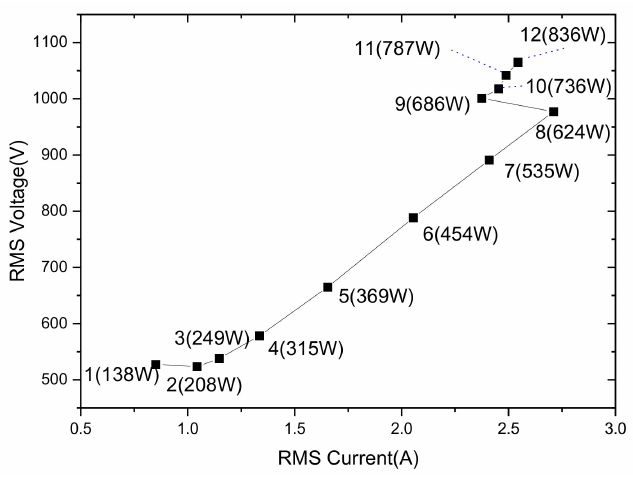
Figure 2. IV curve of 4.4 mm DBD.